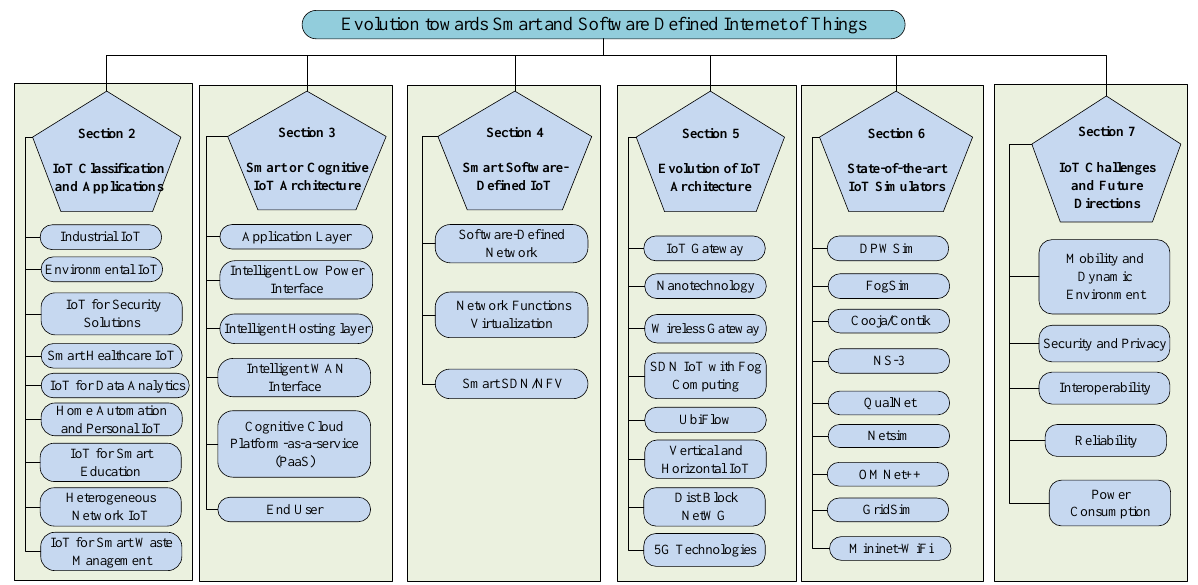
Figure 1. Taxonomy of the